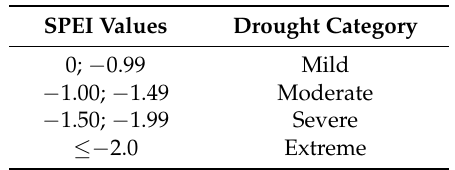
Table 1. Drought classification based on the monthly standardized precipitation evapotranspiration index (SPEI) values, according to the classification proposed by McKee et al.